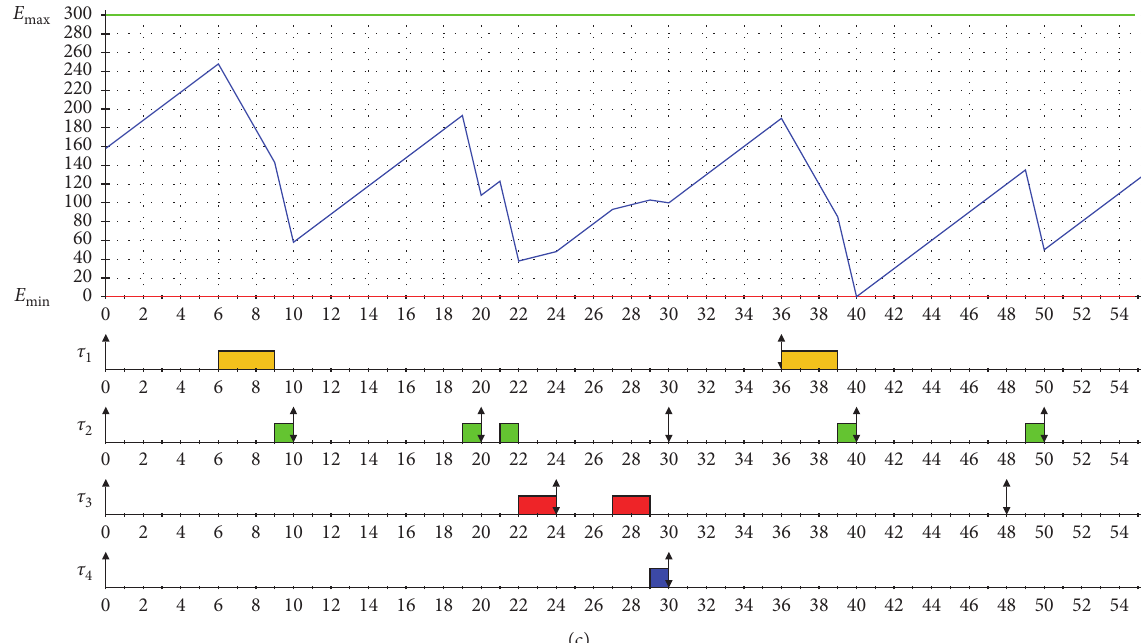
Figure 4: Running status of task set τ T with different initial energies. (a) Fixed initial energy (20). (b) WCRT-IELB algorithm calculating initial energy. (c) AC-IELB algorithm calculating initial